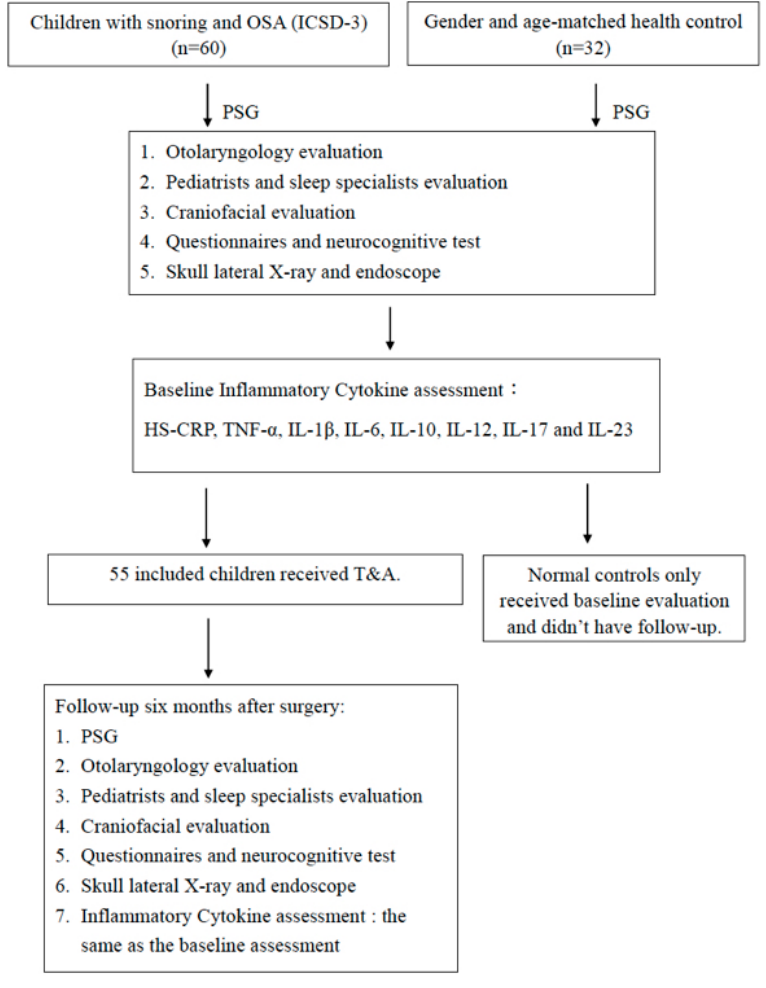
Figure 1. Study flow chart. PSG: polysomnography; T&A: adenotonsillectomy.